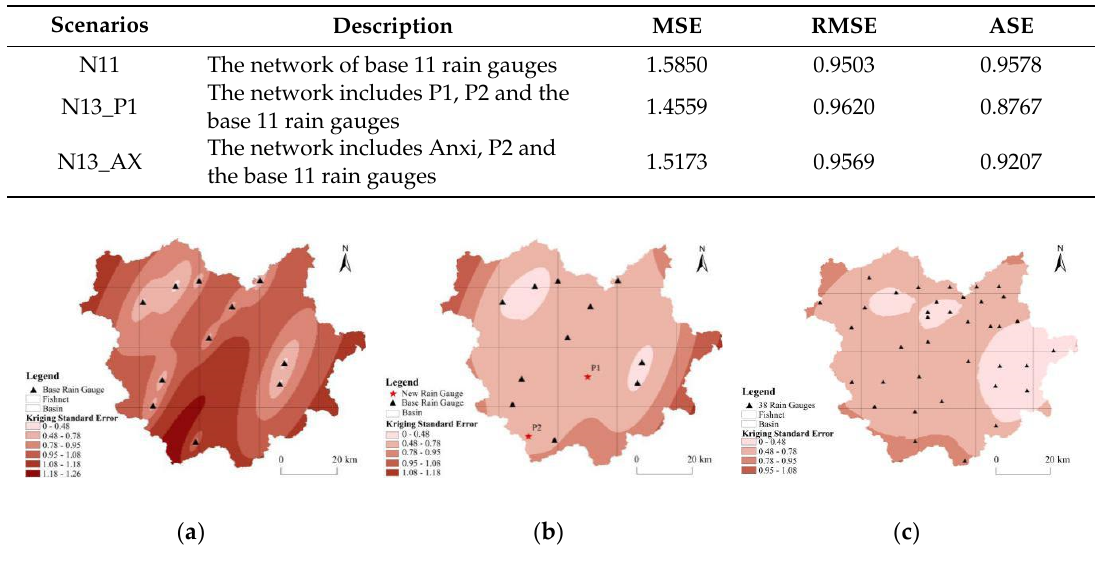
Table 3. Cross-validation statistics of the base rain gauge network and its optimal network.